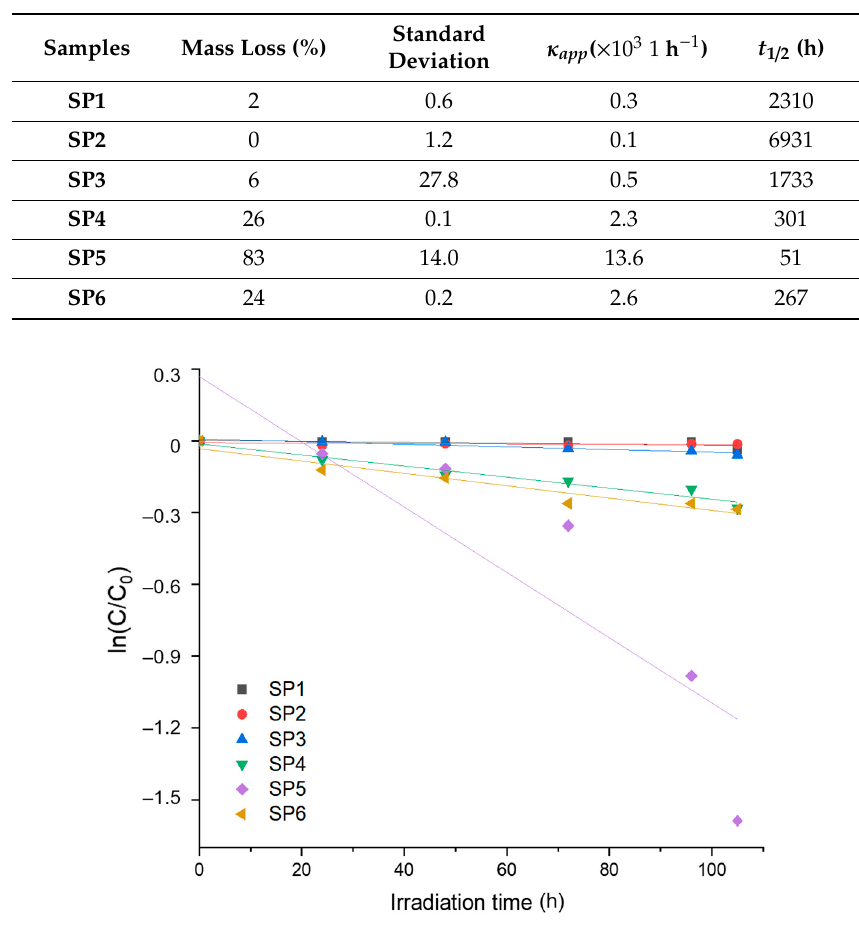
Figure 7. Evaluation of the apparent reaction rate constant ( (cid:2018) (cid:3028)(cid:3043)(cid:3043) ) of SP1-SP6.